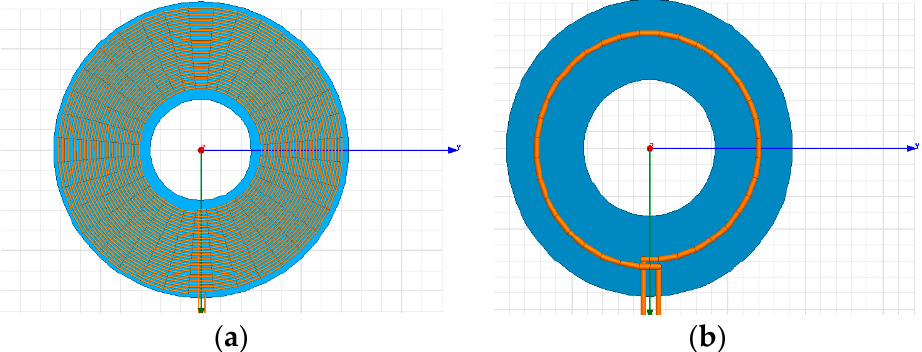
Figure 9. Circular pad model ( a ) and its simplified version ( b ) for the simulations in Ansys®